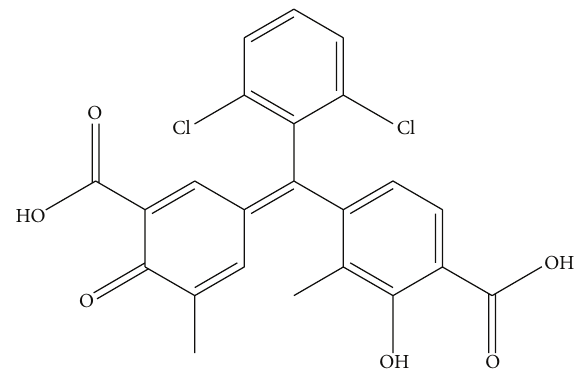
Figure 1: Molecular structure of